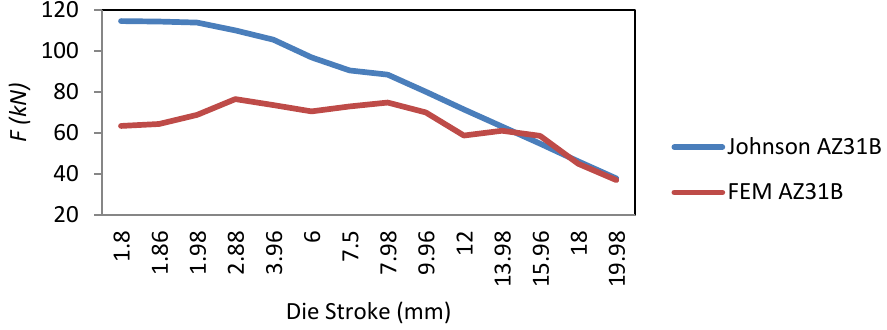
Figure 5. Comparison chart between Johnson and FEM extrusion force for a billet of AZ31B.